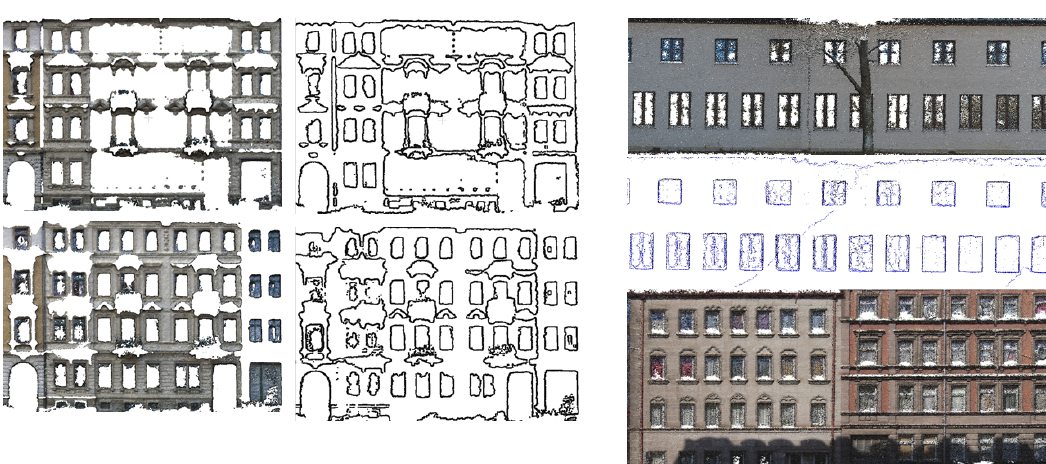
Figure 2: The left side shows two hypothesis from plane-angular sweep segmentation of the same facade and the corresponding outlines are shown on the right. These combined outlines in most cases reveals the correct outlines of windows and doors.